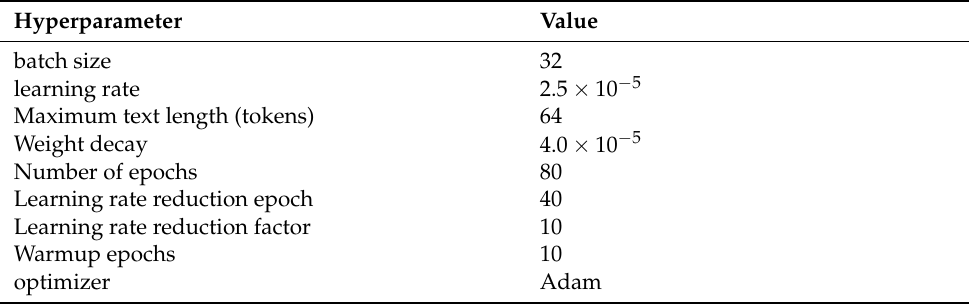
Table 2. The hyperparameters for supervised